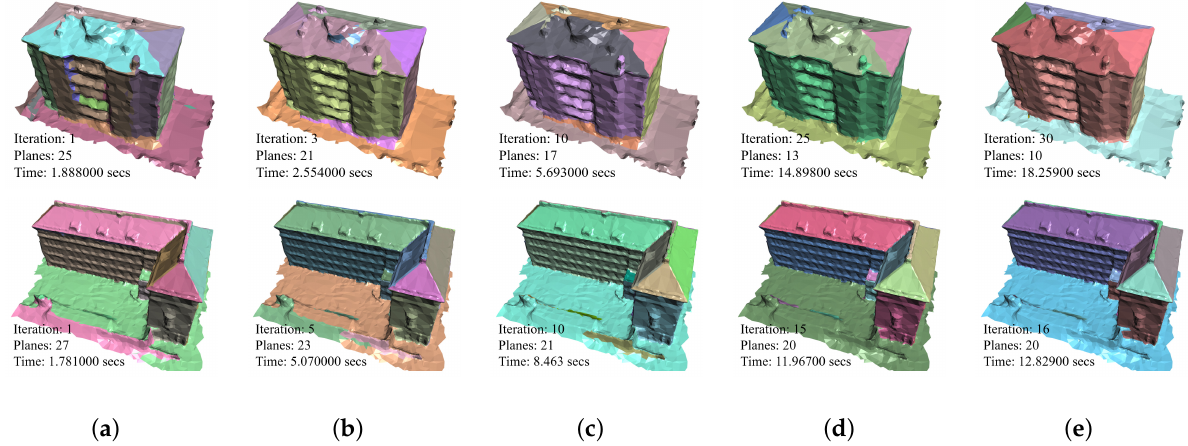
Figure 20. Effect of the number of iterative bootstraps of the segmentation model on segmentation re- sults. ( a ) One iteration, ( b ) Increased iterations, ( c ) Increased iterations, ( d ) Increased iterations, and ( e ) Increased